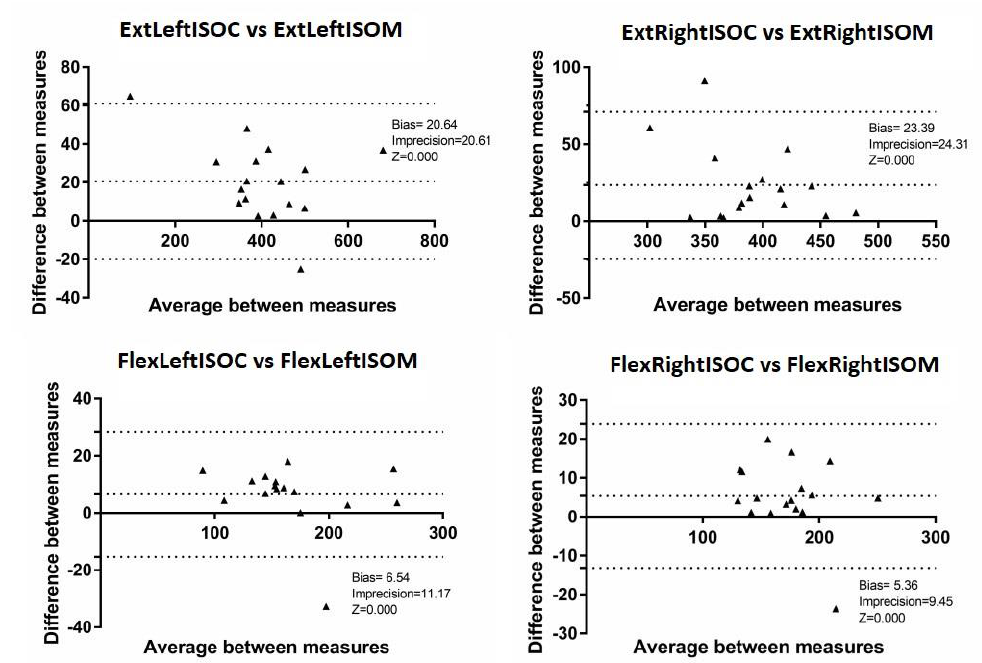
Figure 2. Knee extension and flexion peak isometric forces (N) Bland–Altman plots with both devices ( n = 17). ExtLeftISOC = left knee extension with ISOC, ExtLeftISOM = left knee extension with ISOM, ExtRightISOC = right knee extension with ISOC, ExtRightISOM = right knee extension with ISOM, FlexLeftISOC = left knee flexion with ISOC, FlexLeftISOM = left knee flexion with ISOM, FlexRightISOC = right knee flexion with ISOC, FlexRightISOM = right knee flexion with ISOM.